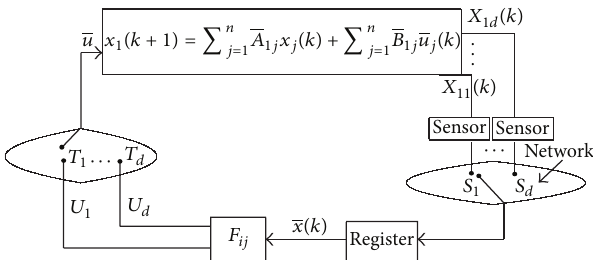
Figure 3: The structure of an NCS with both S/C and C/A